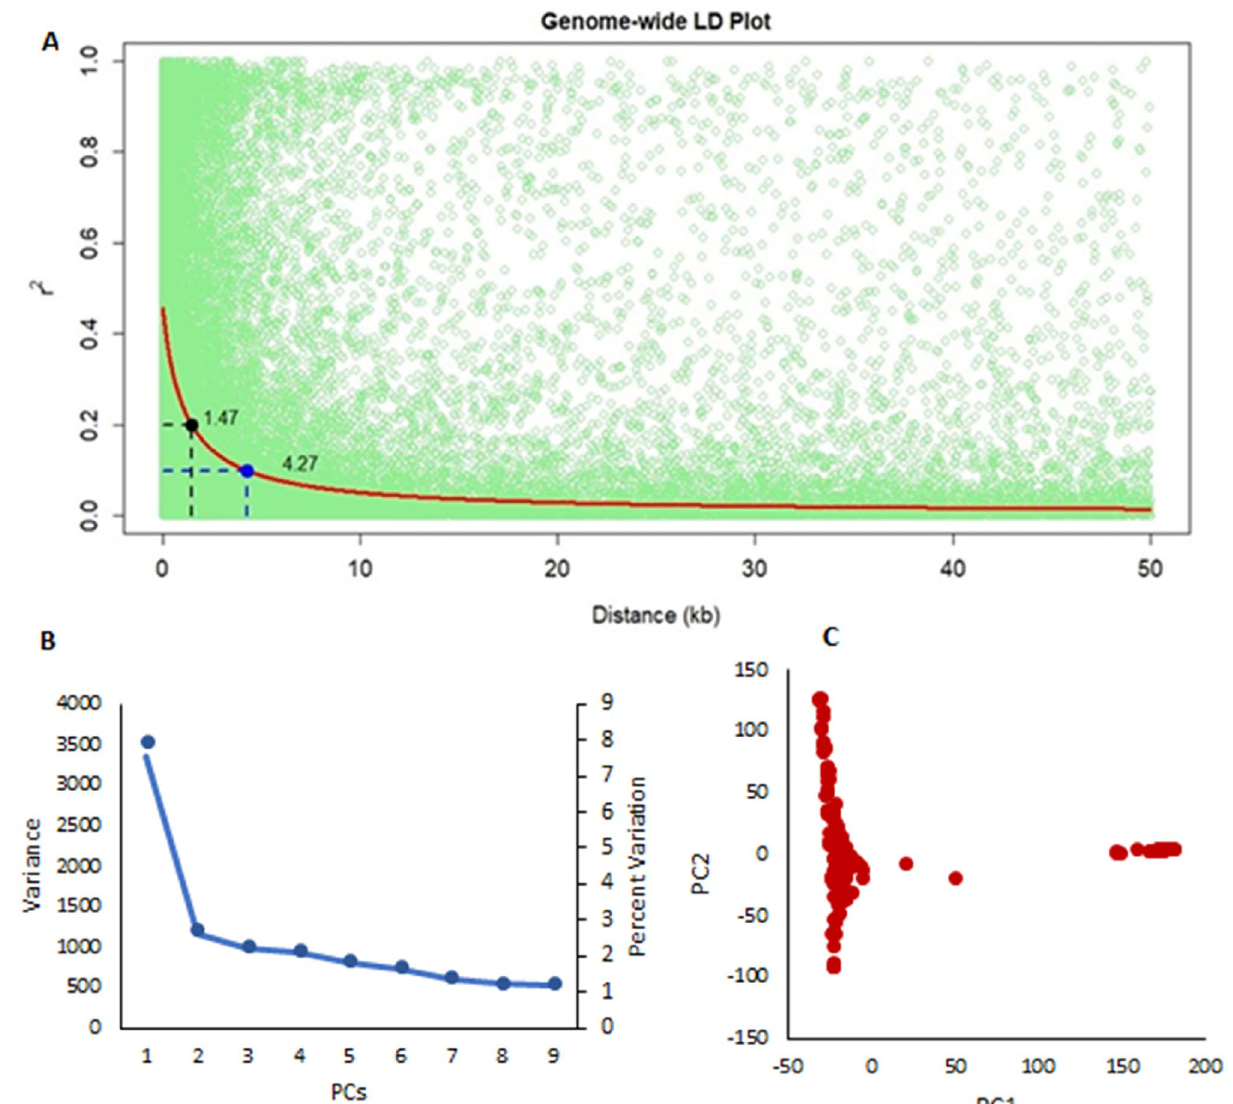
Figure 3. LD-decay ( A ), scatter plots of 10 PCs ( B ) and population structure as expressed by first two PCs ( C ) observed among the panel of Asia-adapted tropical